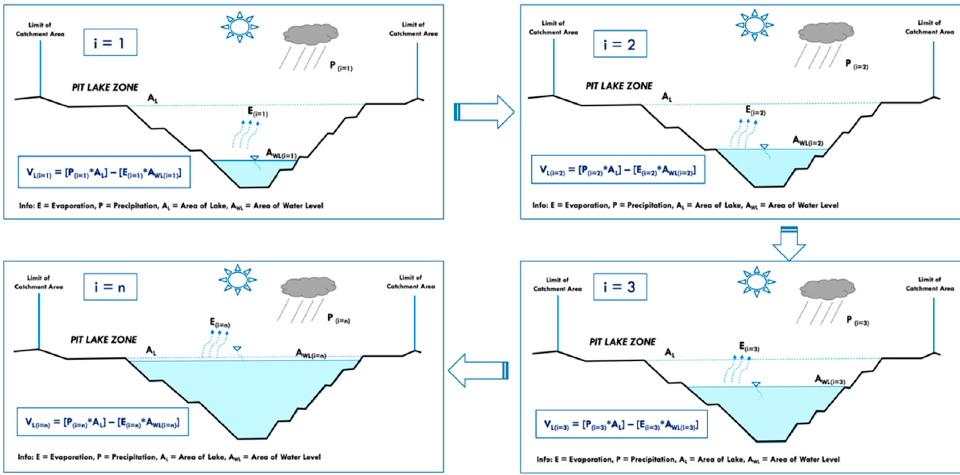
Figure 5. Pit Lake Zone.